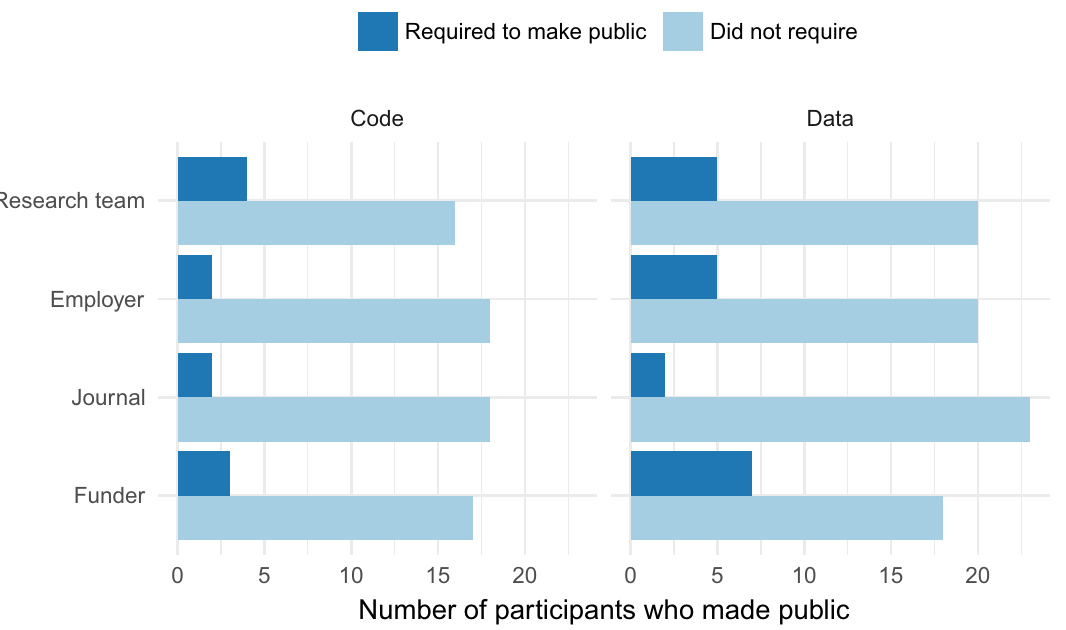
Fig 1. Of participants who made data (n = 25) or code (n = 20) publicly available, which (if any) entity required the data or code to be public? These responses are from the reproducibility of statistical analyses section of the survey.